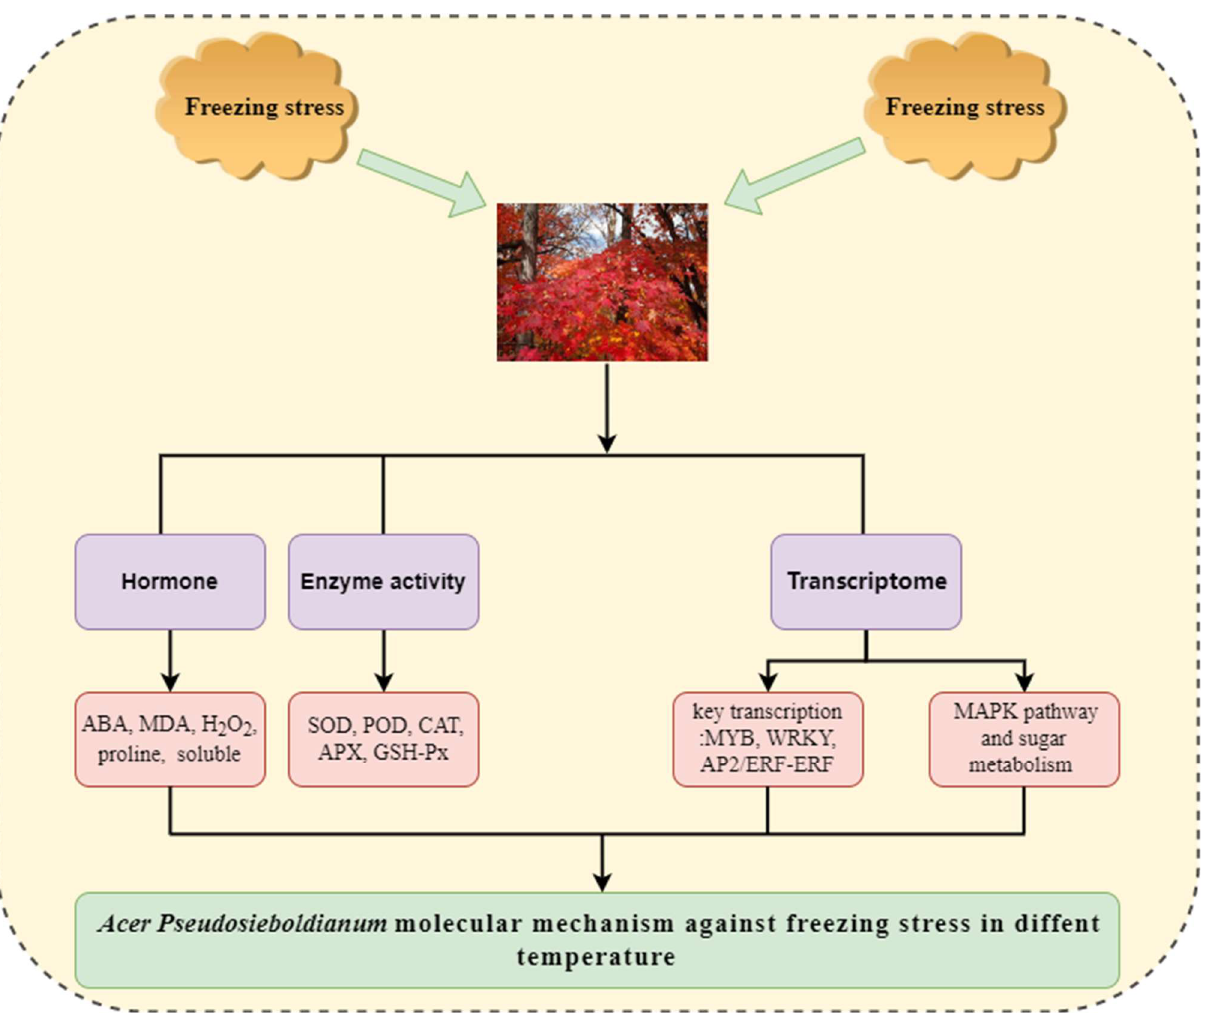
Figure 10. A. pseudosieboldianum freezing stress summary figure .